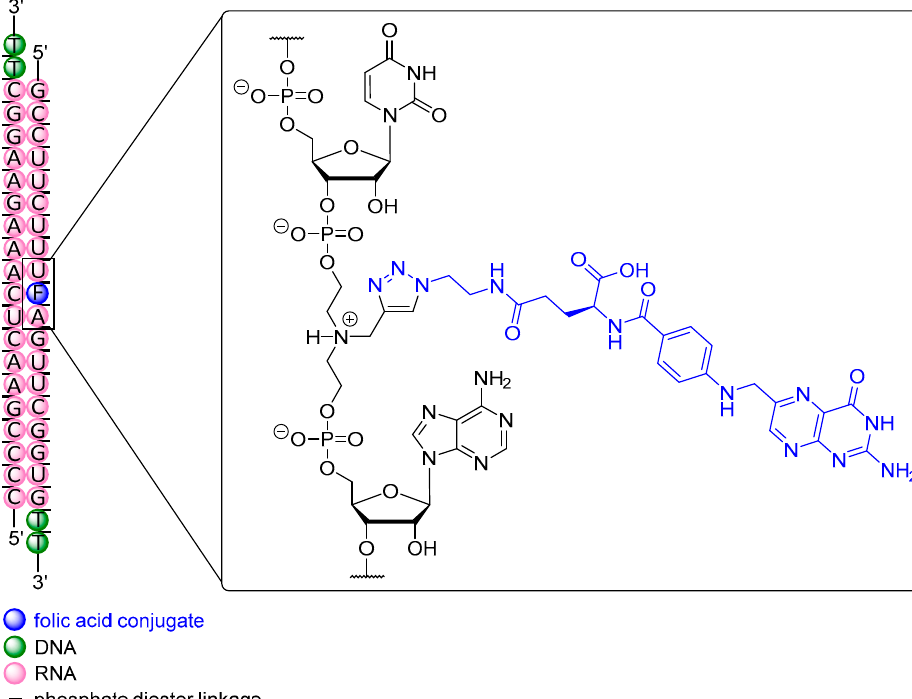
Figure 4. Internally modified folic acid-siRNA (passenger strand) for the silencing of Bcl-2 expression. The 5 ′ -ends of siRNA strands are phosphorylated (not shown).